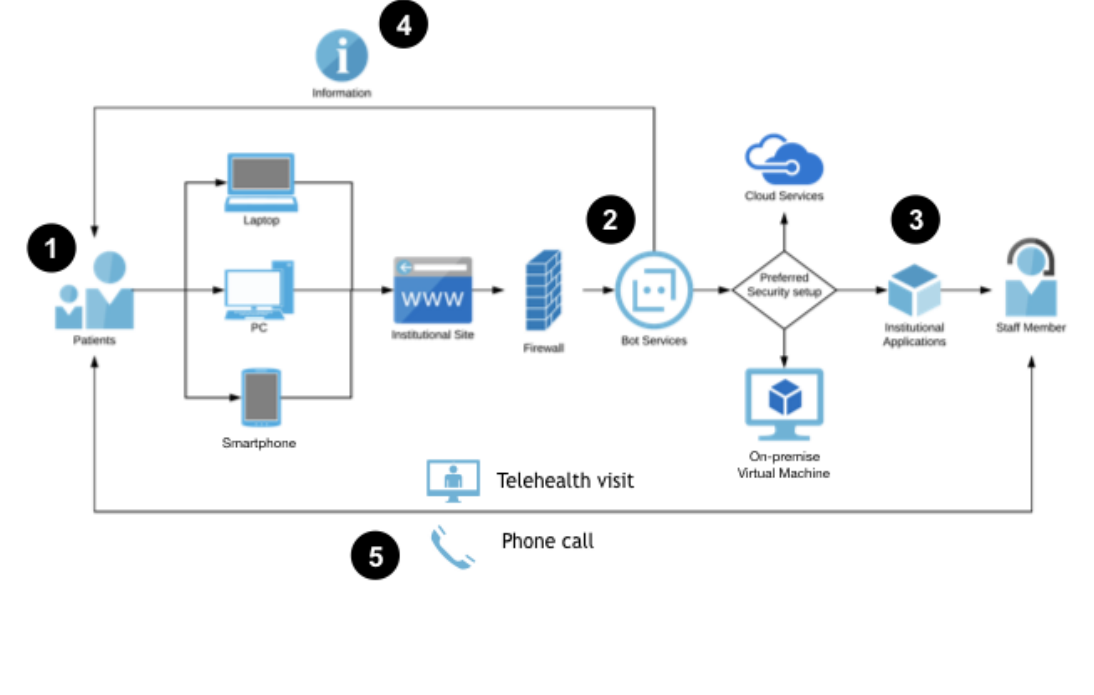
Figure 3. A chatbot network diagram: provider-initiated approach. This diagram illustrates a generic architecture and workflow for a chatbot that is hosted within the institution’s secure computing environment. 1) The patient uses a personal device to access the institution’s website from a link they receive in a text, email, or secure message. 2) The chatbot interacts with the patient and stratifies them according to the screening algorithm. 3) The chatbot collects data and integrates with institutional workflows, including additional clinical screening and scheduling. 4) The chatbot provides the patient with education, resources, tips, and specific instructions on next steps. 5) Staff members reach out to patients to schedule appropriate follow-up; patients are also able to reach out with further questions or